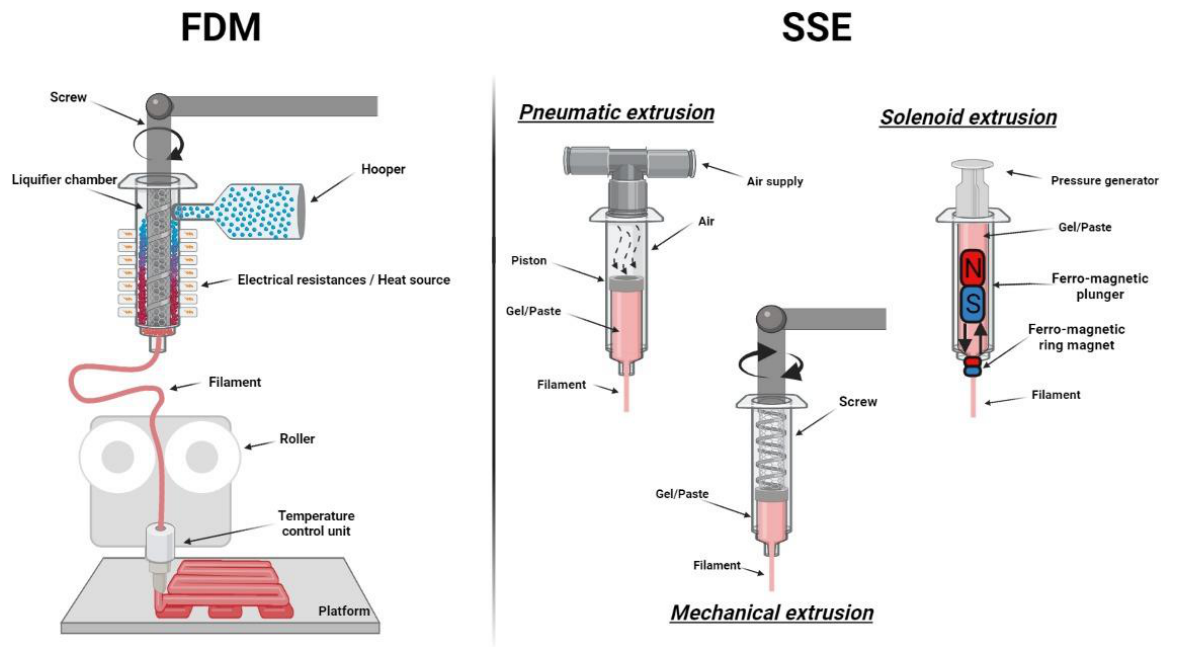
Figure 2. Extrusion based techniques, fused deposition modeling (FDM) ( left ) and semisolid extrusion (SSE) mechanisms ( right ).